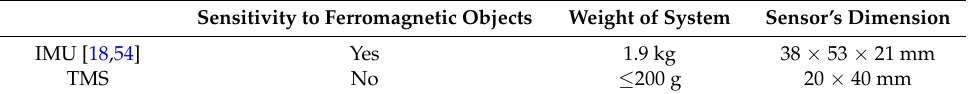
Table 5. Comparison between IMU and